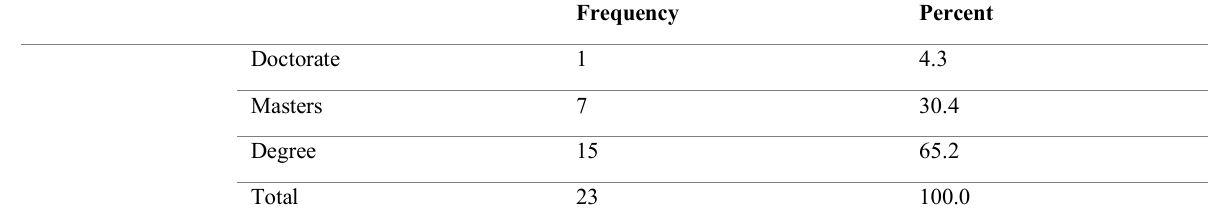
Table 1: Education of